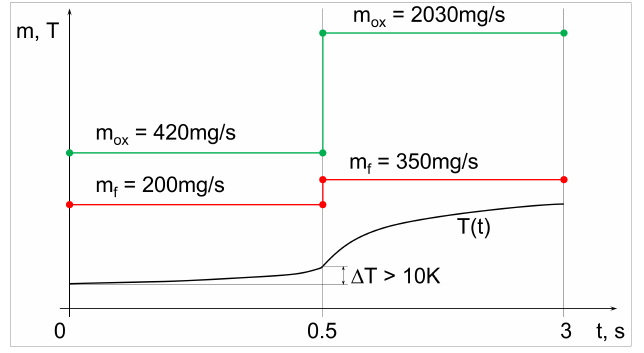
Figure 7. Ignition sequence optimal parameters.